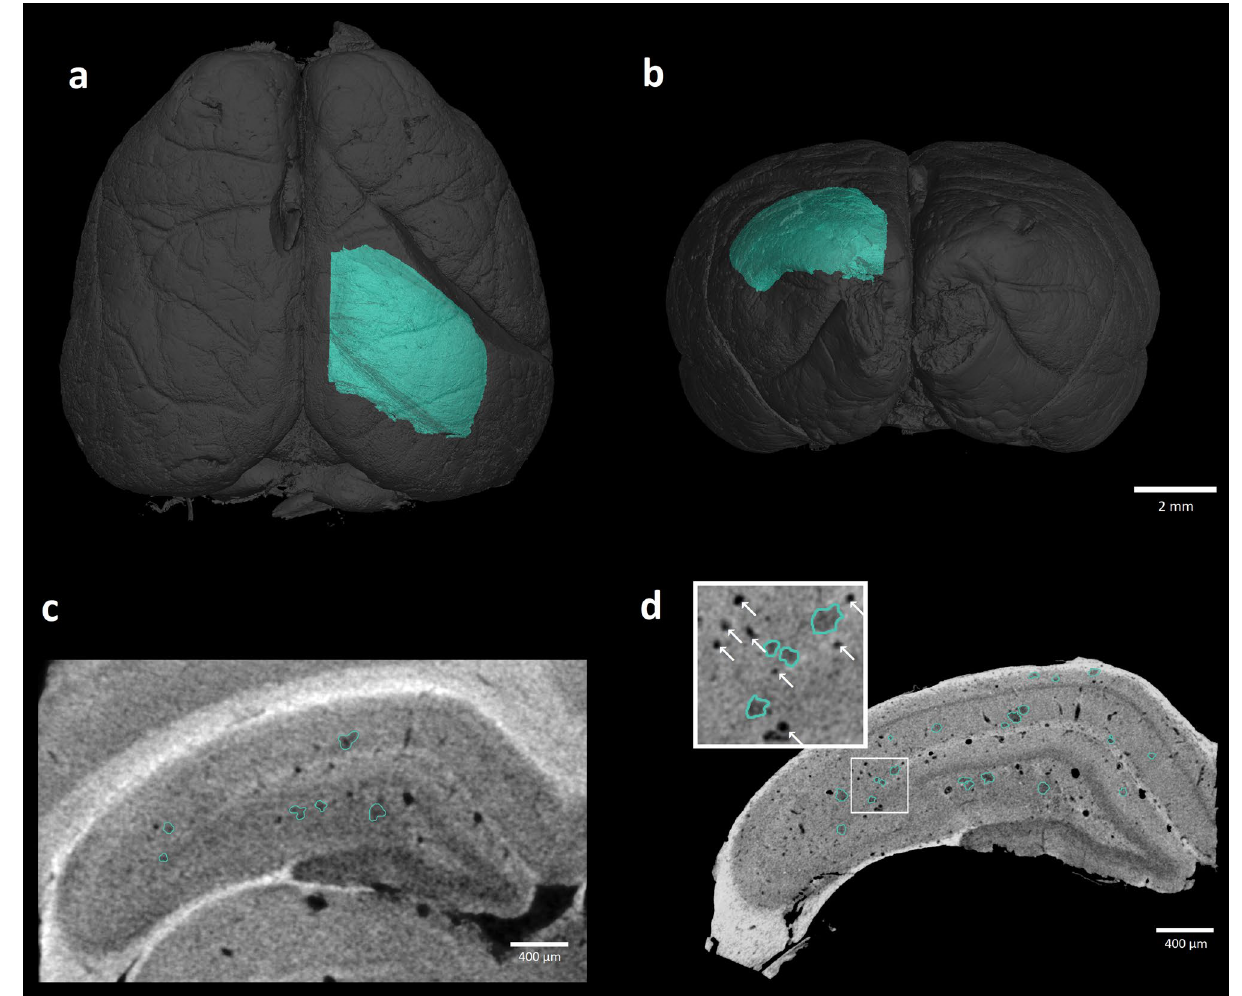
Figure 2. Detailed scan of the dissected dorsal hippocampus: Horizontal ( a ) and coronal ( b ) reconstructed view of the brain with dissected right dorsal hippocampus (green) used for the isolated scan. The same hippocampal tissue sample imaged by two different micro CT approaches ( c , d ) where the suspect plaques are highlighted in green. Panel ( c ) shows the section taken from the whole brain scan. Panel ( d ) depicts the same area after the isolated scanning that achieved smaller voxel size, in the magnified image the blood vessels are labeled by white arrows 41,42 by median value 38,423 µm 3 and IQR of 57,512 µm 3 . The distribution of the Aβ plaques in 3D space with their color coded volumes is shown in Fig. 4a. Next, we assessed the shapes’ variability of Aβ plaques by measuring their compactness. The volume of the plaque was divided by the volume of the sphere circumscribed to the plaque. The values ranged between 0–1 where score of one represented a perfect sphere (Fig. 4b). The identified plaques had median of compactness at 0.396 with interquartile range 0.135. To alleviate supposed bias that could be caused by an eventual imperfection in defining boundaries in the smaller plaques, we additionally restricted the measurement to subset of plaques with volume larger than its median value (50% of the population). The corresponding compactness had a comparable median of 0.383 and IQR of 0.149. A precise 3D model of the plaque occurrence in the hippocampal sample allowed to quantify their spatial distribution including the relation to other labeled structures. We evaluated the distances of plaques to the nearest blood vessel and the inter-plaque distance (Fig. 5). The reconstructed 3D model returned the median distance between the plaques and the nearest vessel of 64.5 µm with IQR 62.3 µm (Fig. 5a). We then investigated whether their relation followed a non-random pattern. For each of the 1666 plaques we generated a random coordinate within the dissected part of hippocampus, leaving out the detected blood vessels. We measured the respective distances of generated “plaques” to a nearest vessel with median of 89.1 µm and IQR 103 µm. The comparison between the sets of experimental and randomly generated data returned the plaque-vessel distance significantly shorter in experimental data than in the random sample (Z = 10.95, p < 0.001, Mann Whitney U test), indicating the plaques tended to appear closer to the blood vessels than if their distribution was random. Finally we tested whether the plaques aggregated together irrespectively of the vessels. The same method of generating dataset with random positions was applied, and the distances between the two closest plaques were measured within the